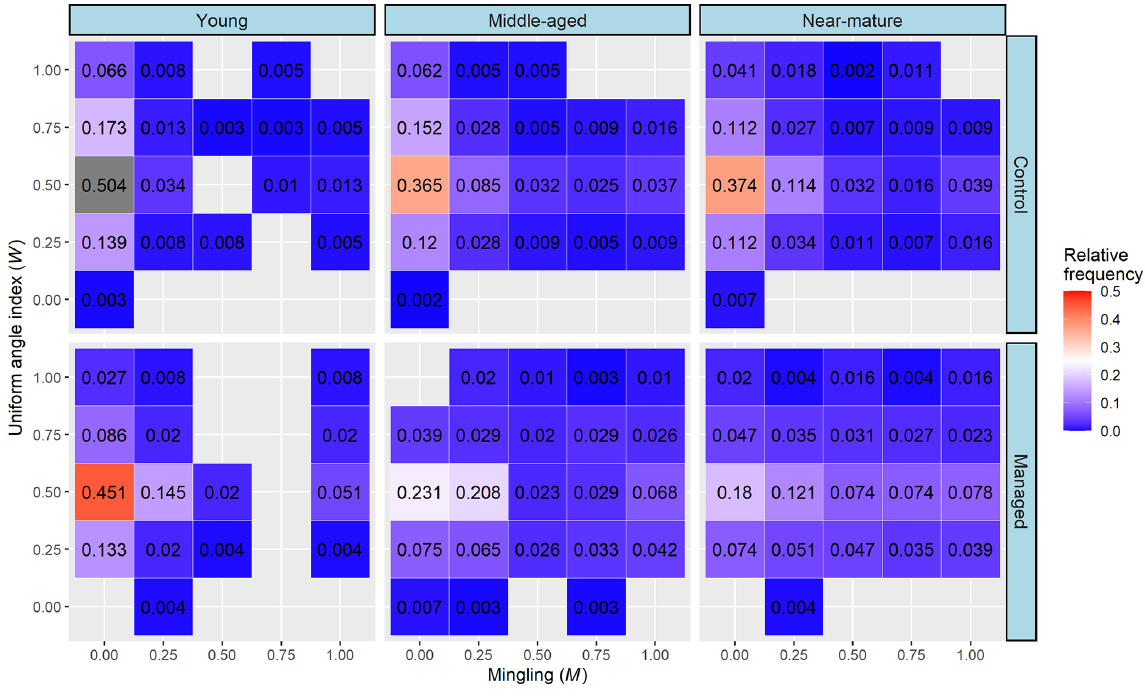
Figure 4. Bivariate distribution of M and W at different tree ages.